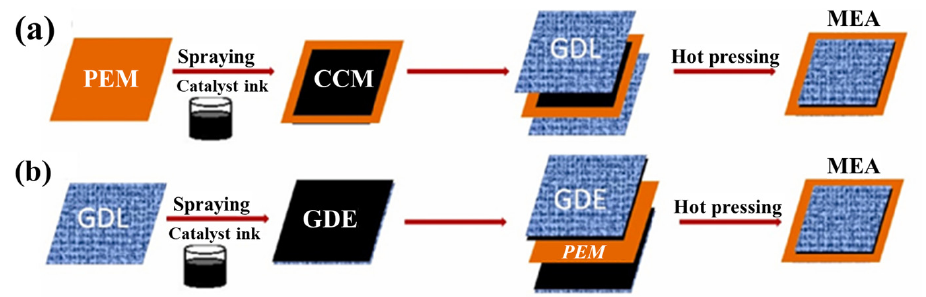
Figure 4. Preparation process of MEA: ( a ) CCM and ( b ) GDE methods. Reprinted with permission from Ref. [83]. Copyright 2021, Elsevier.